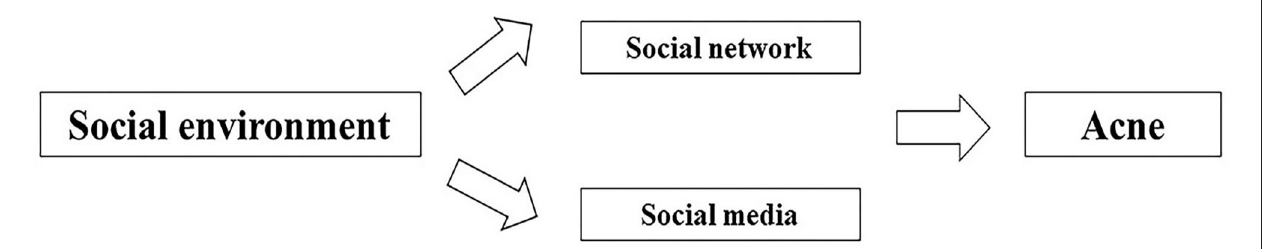
FIGURE 4 | Factors of social environment affecting